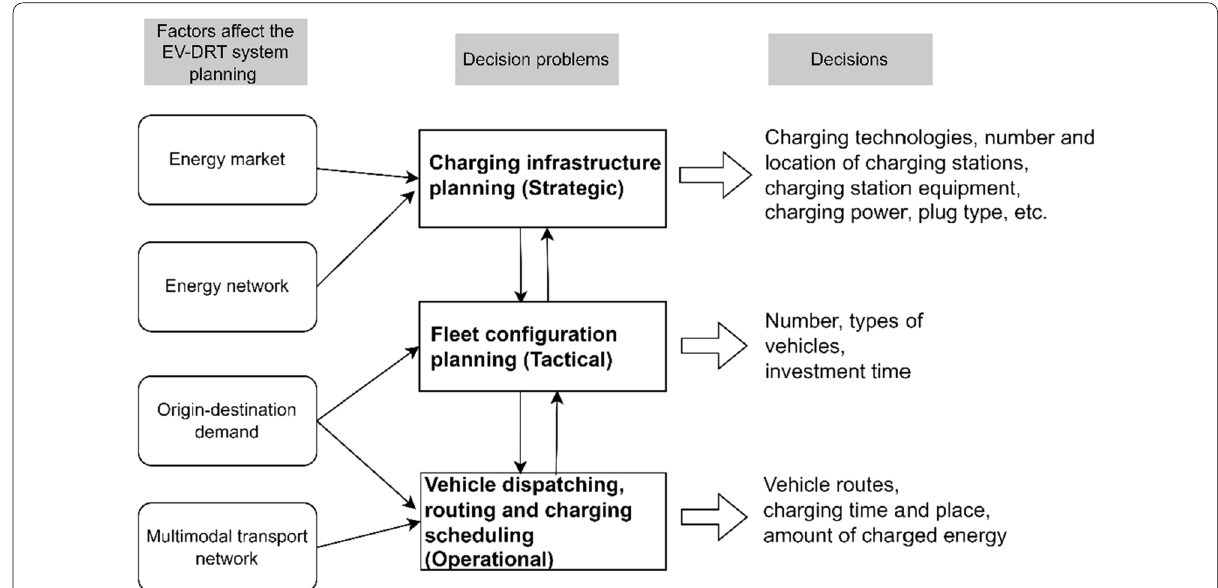
Fig. 2 Strategic, tactical, and operational decisions for EV‑DRT system planning and their